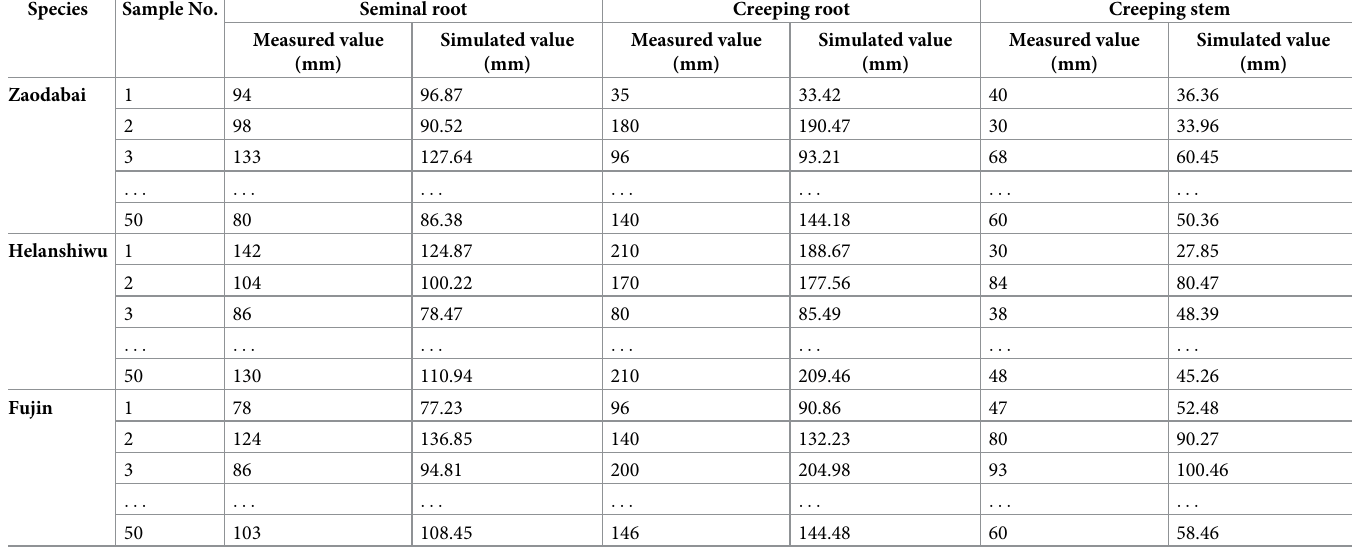
Table 2. Simulated and measured root depth. Species Sample No. Seminal root Creeping root Creeping stem Measured value